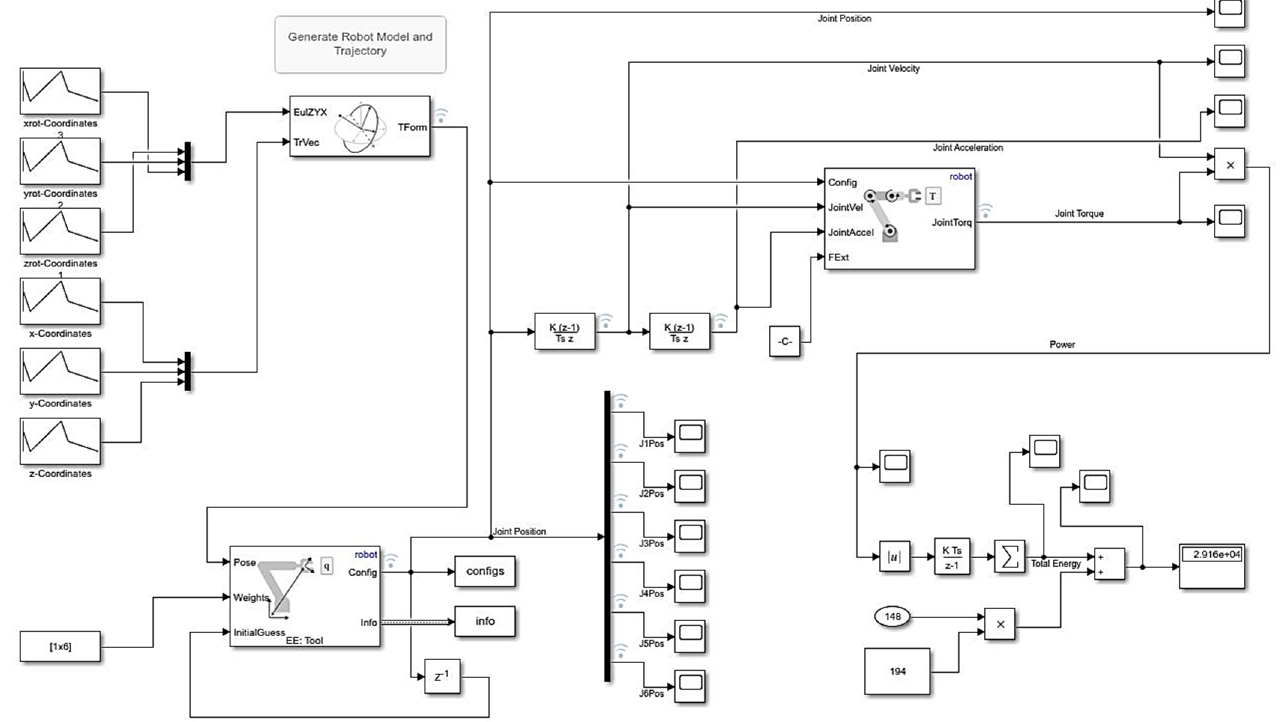
Figure 7. Simulink block diagram for path definition and inverse kinematic.